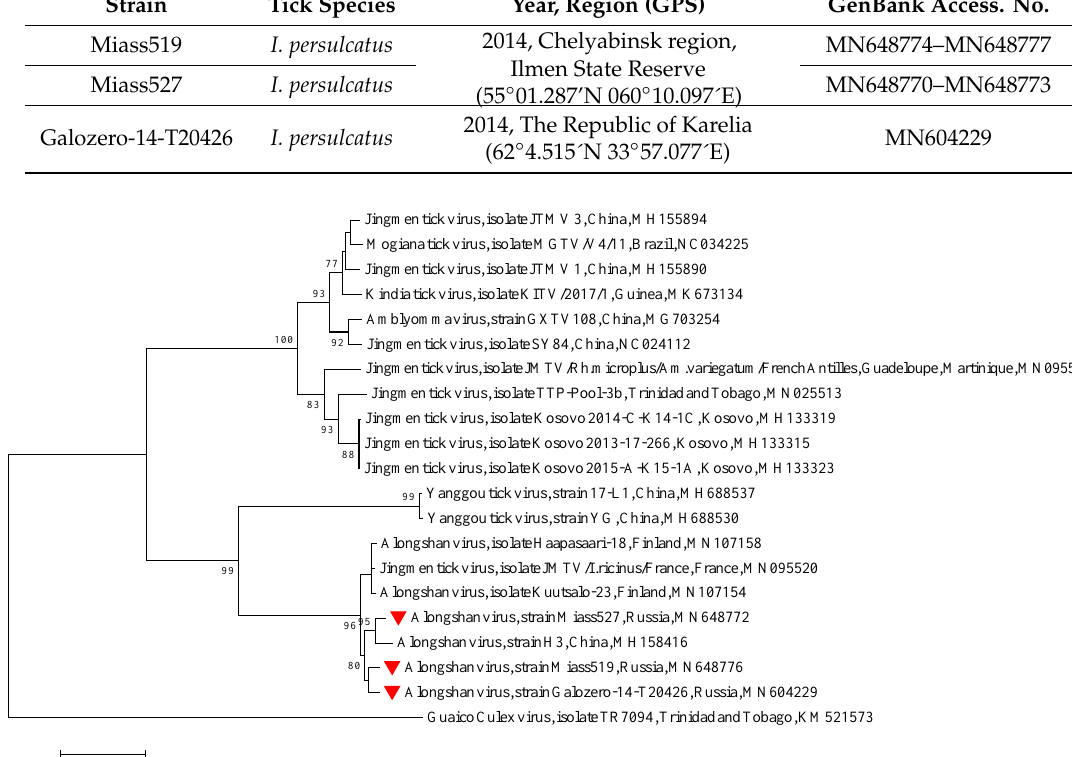
Figure 2. Phylogenetic tree of a 1,732 bp fragment of segment 2 of Alongshan virus and other members of the Jingmenvirus group. Phylogenetic trees were constructed using MEGA 6.0 with the neighbour-joining method (1000 bootstrap replications). Bootstrap values ( > 70%) are shown at the branches. GenBank accession numbers are listed for each strain. (cid:72) Strains from the present